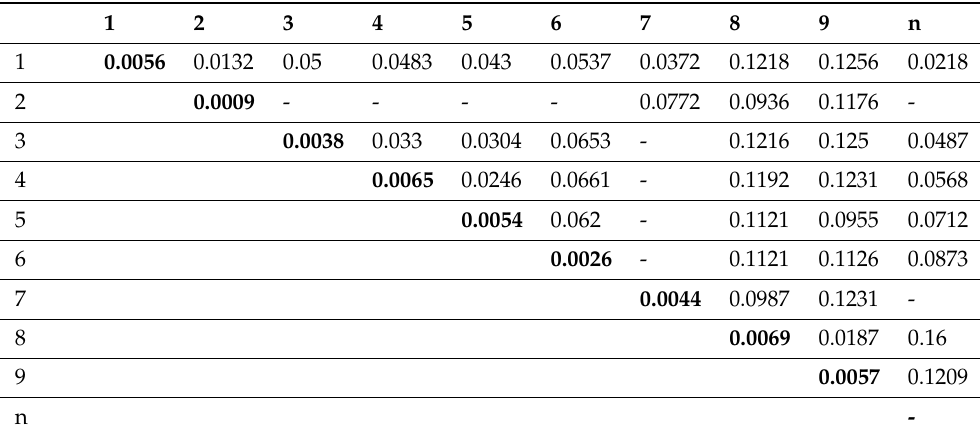
Table 2. Mean pairwise genetic distances within and among major clades based on the combined mitochondrial dataset and following the clade numbers in Table